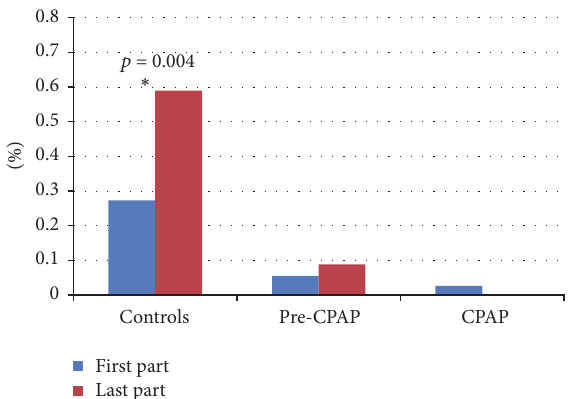
Figure 3: Percentage of time occupied with central spindle sequences in the first and last part of the NREM sleep. The statistically significant differences are marked with asterisk and denoted with the 𝑝 values.